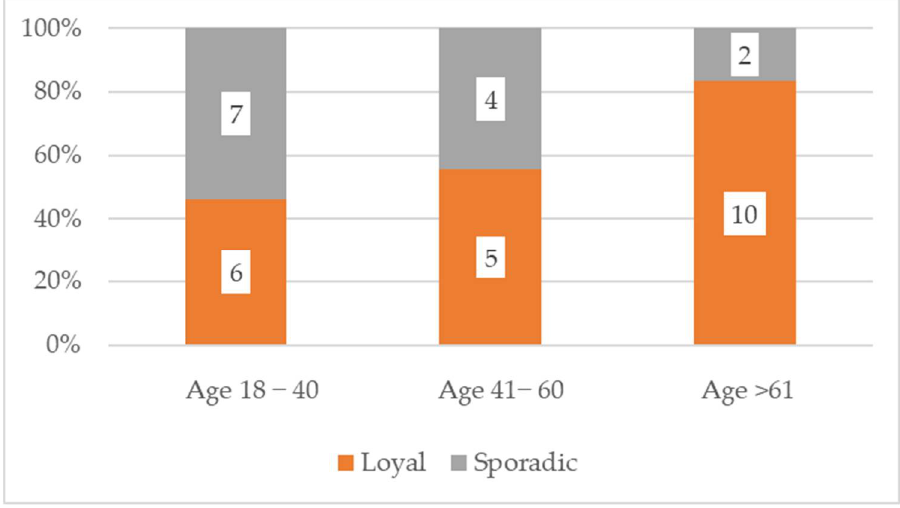
Figure 4. Attendance and loyal and sporadic consumers. Source: The authors.